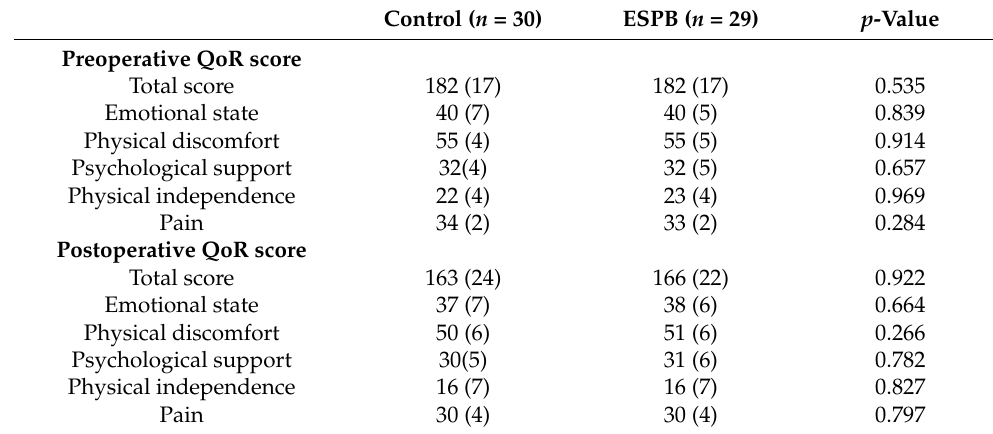
Table 3. Quality of recovery